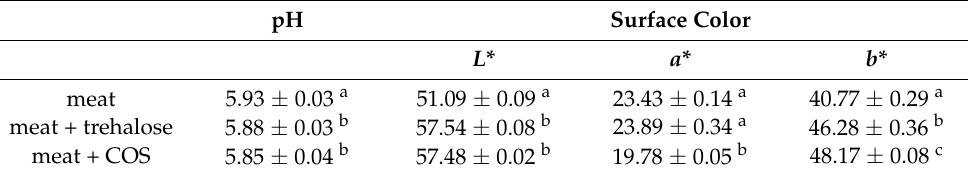
Table 3. The pH value and surface color of meat with different treatments.